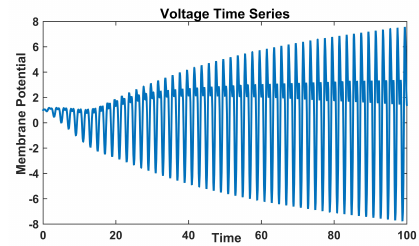
Figure 30. Recovery variable (right) with pa- rameter values a = 0.7, b = 2, c = 3